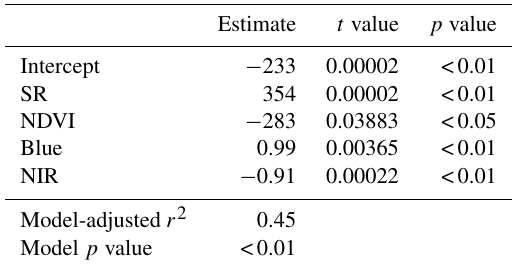
Table 3. Model summary utilizing spectral data to estimate CH 4